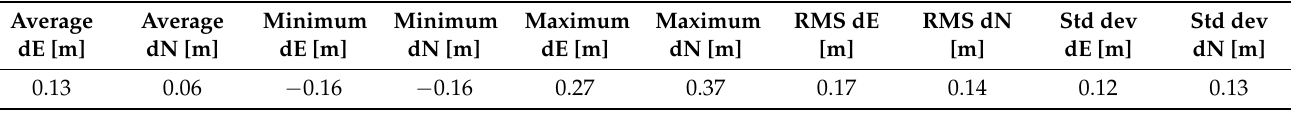
Table 4. Summary of statistical accuracy parameters for plane